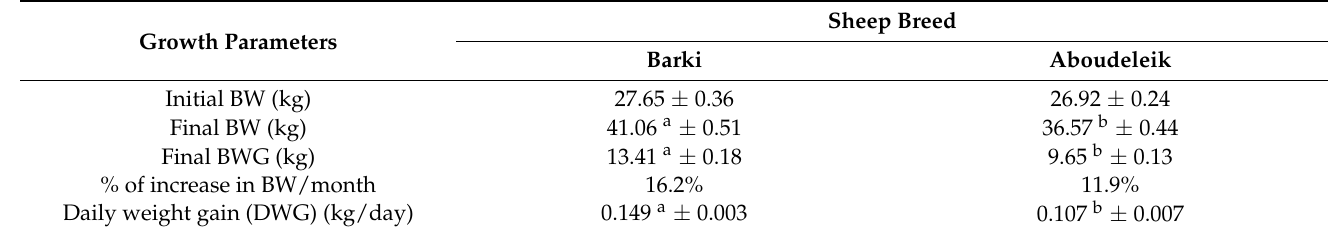
Table 3. Growth performance criteria of Barki and Aboudeleik lambs from the third to the sixth month of